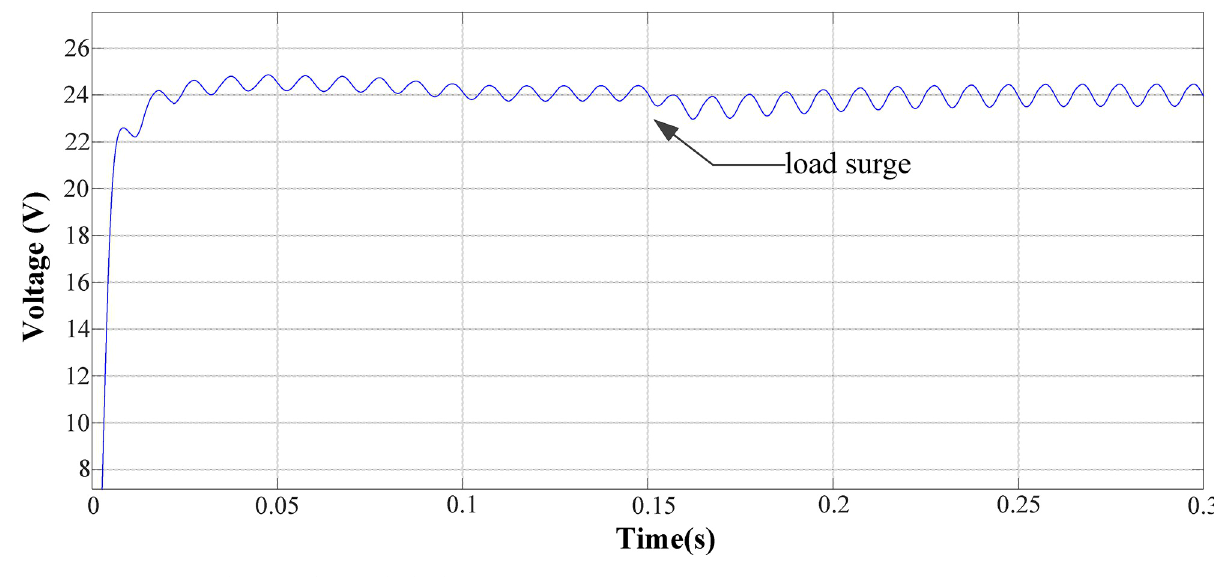
bance recovery time was shorter, and the system robustness was significantly enhanced.